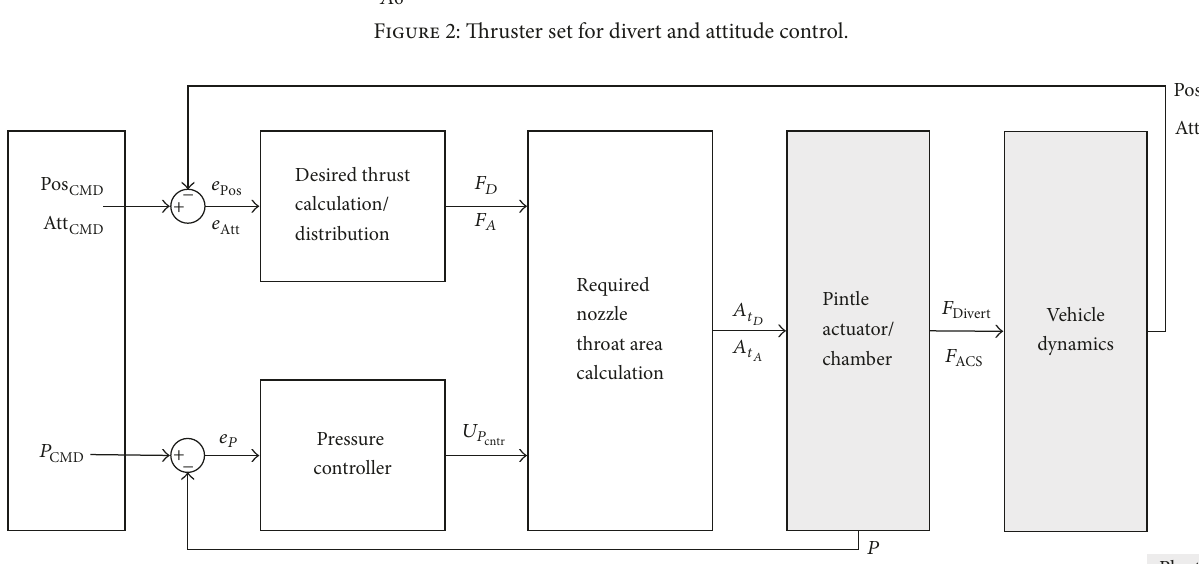
Figure 3: Pintle actuator control